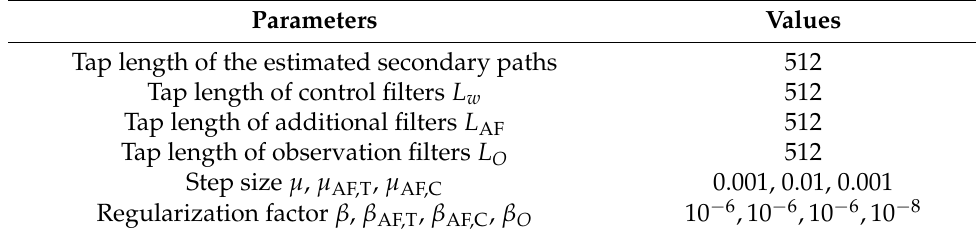
Table 1. Common measurement conditions in all